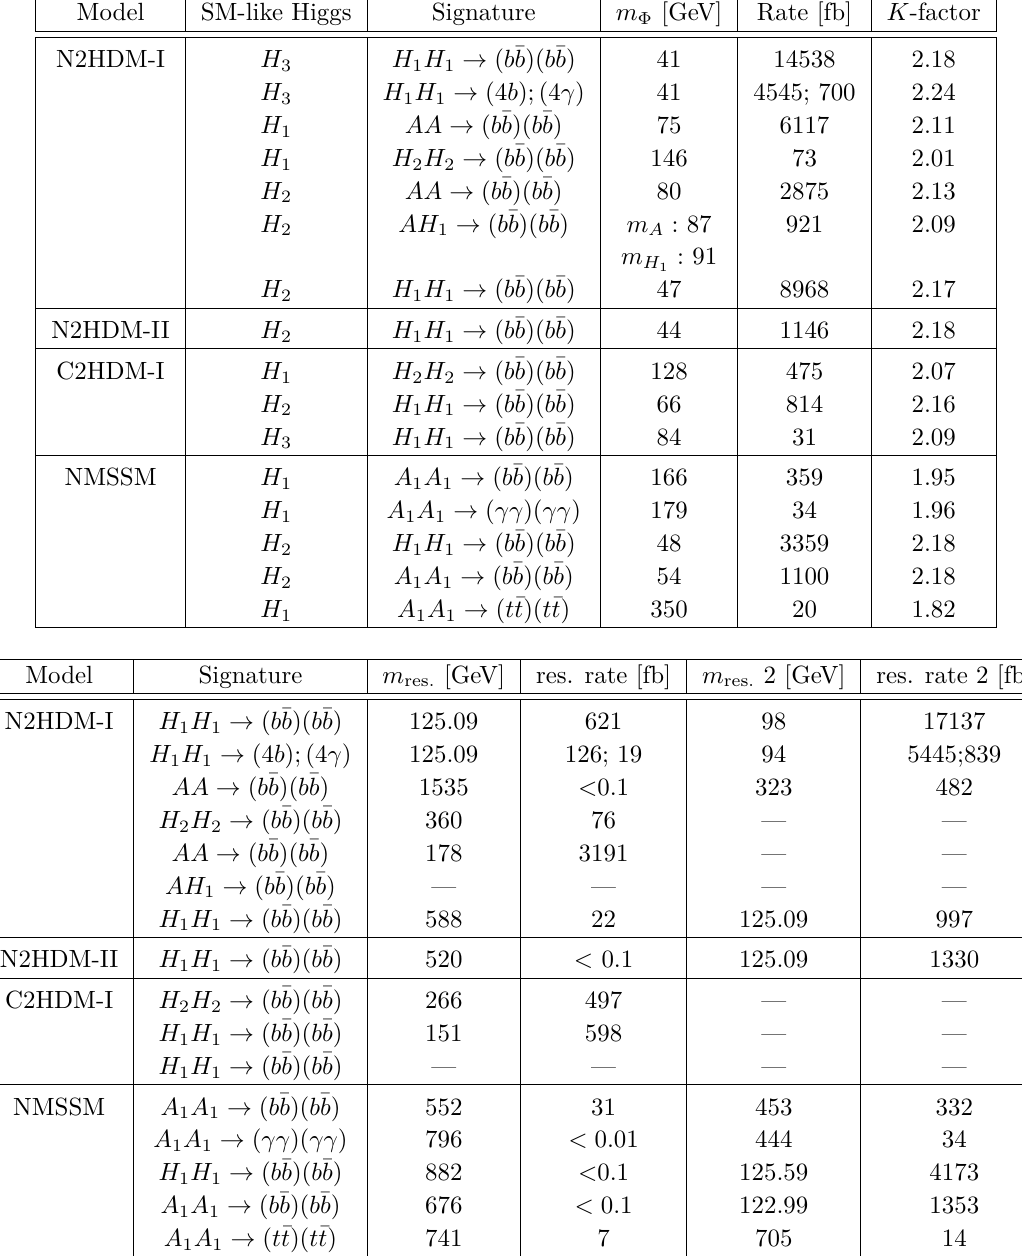
Table 37 . Upper: selected rates for non-SM-like Higgs pair final states at NLO QCD. We specify the model, which of the Higgs bosons is the SM-like one, the signature and its rate as well as the K -factor. In the fourth column we also give the mass value m of the non-SM-like Higgs Φ boson involved in the process. Lower: in case of resonantly enhanced cross sections, the mass of the resonantly produced Higgs boson is given together with the NNLO QCD production rate. Some scenarios contain two heavier Higgs bosons that can contribute to resonant production. All benchmark details can be provided on